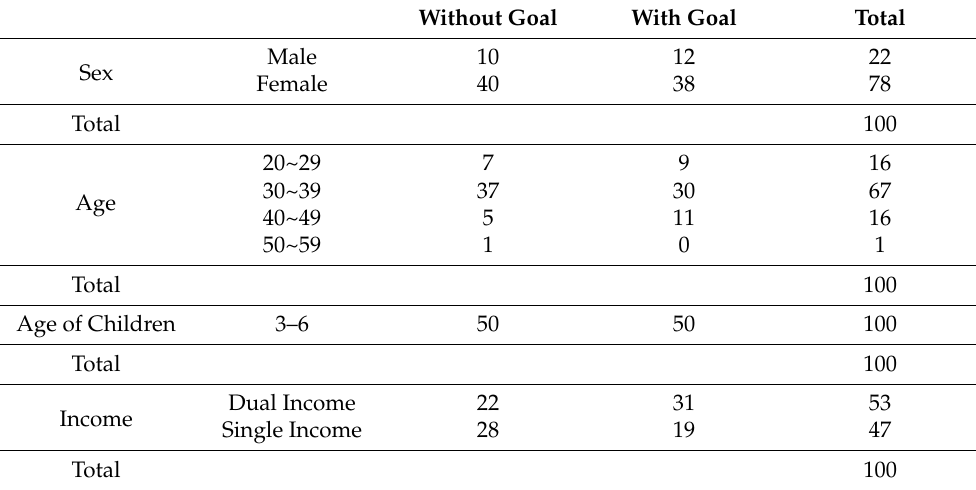
Table 2. Study 2 sample